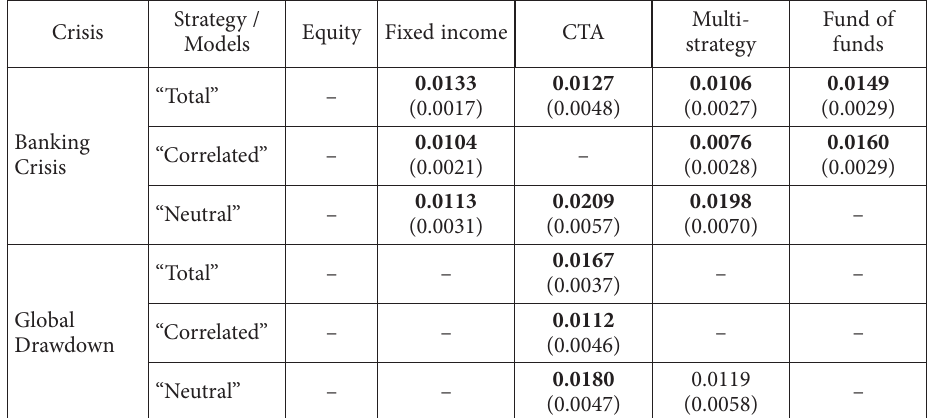
Table 13. Nordic hedge fund panel data crisis